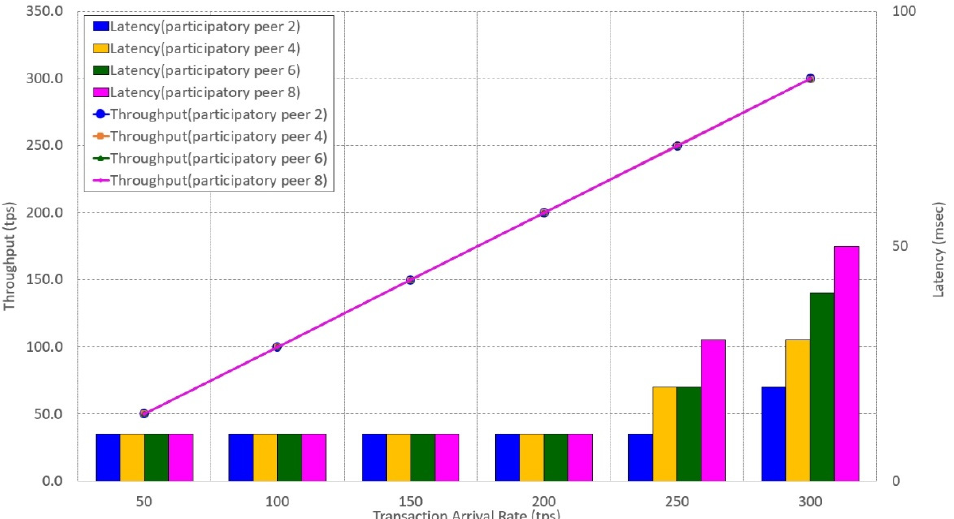
Figure 13. Performance of read in BC of proposed framework under different workloads and different number of peers.